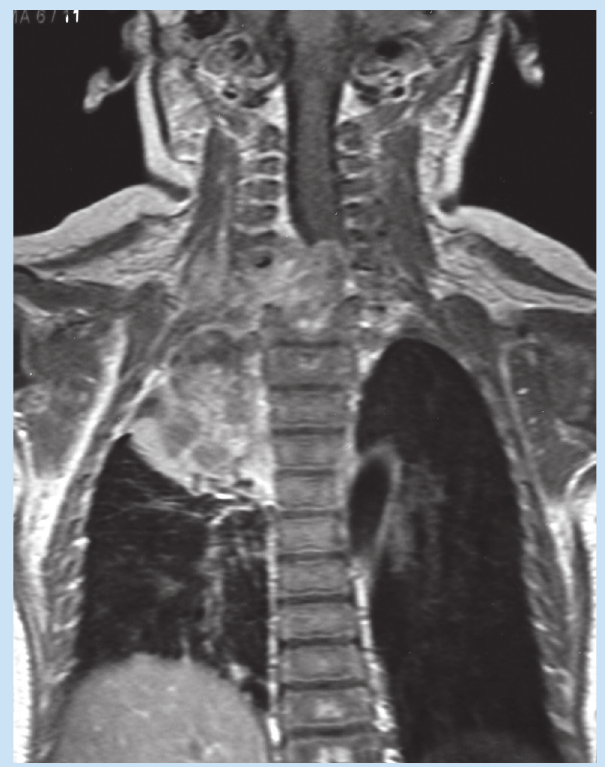
Fig 1. A 4-month-old boy with pulmonary blastoma - coronal T1-weighted post-gadolinium-enhanced image shows the mass extending into the spinal canal with a large extradural component.